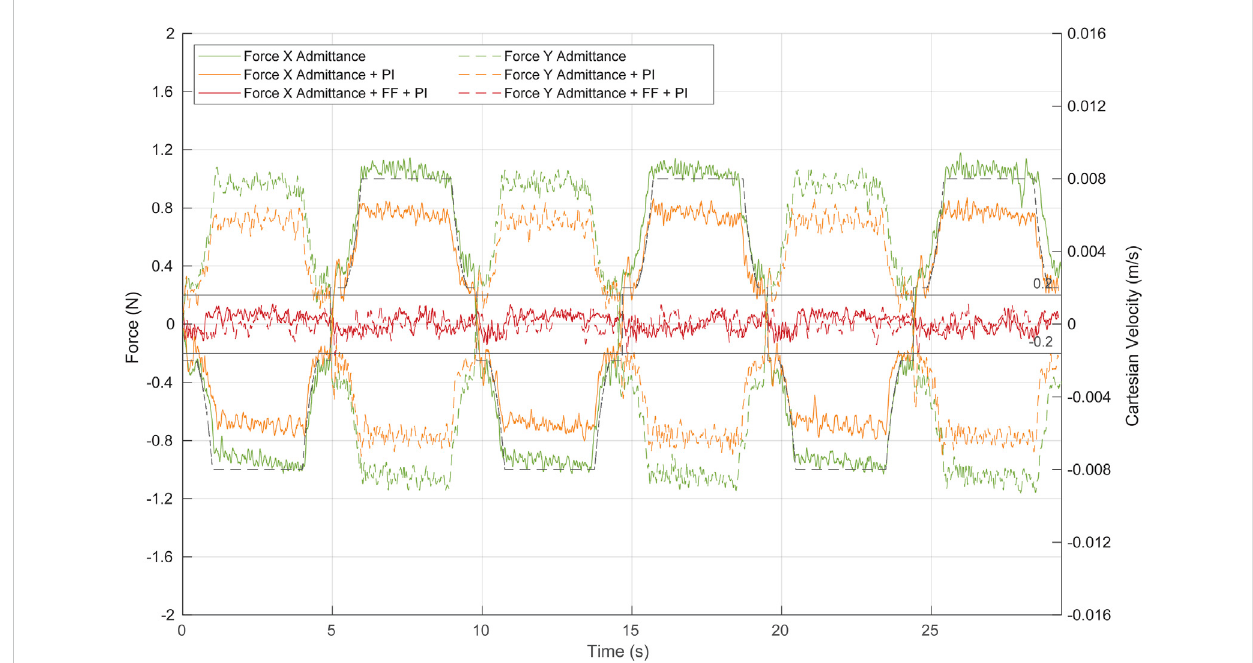
FIGURE 11 Force at the trocar during Cartesian movement of the TCP by the combination of the different control algorithms. Green, admittance control; orange, admittance control and PI; red, complete control strategy: admittance control, PI, and ff. Continuous lines represent forces at the X -axis, while dashed lines show forces at the Y -axis. The dashed black line represents the TCP Cartesian speed at the Y